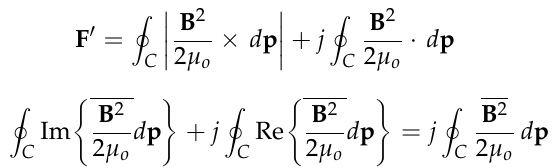
Figure 13. Generic closed curve C inside the complex plane embracing an area A .